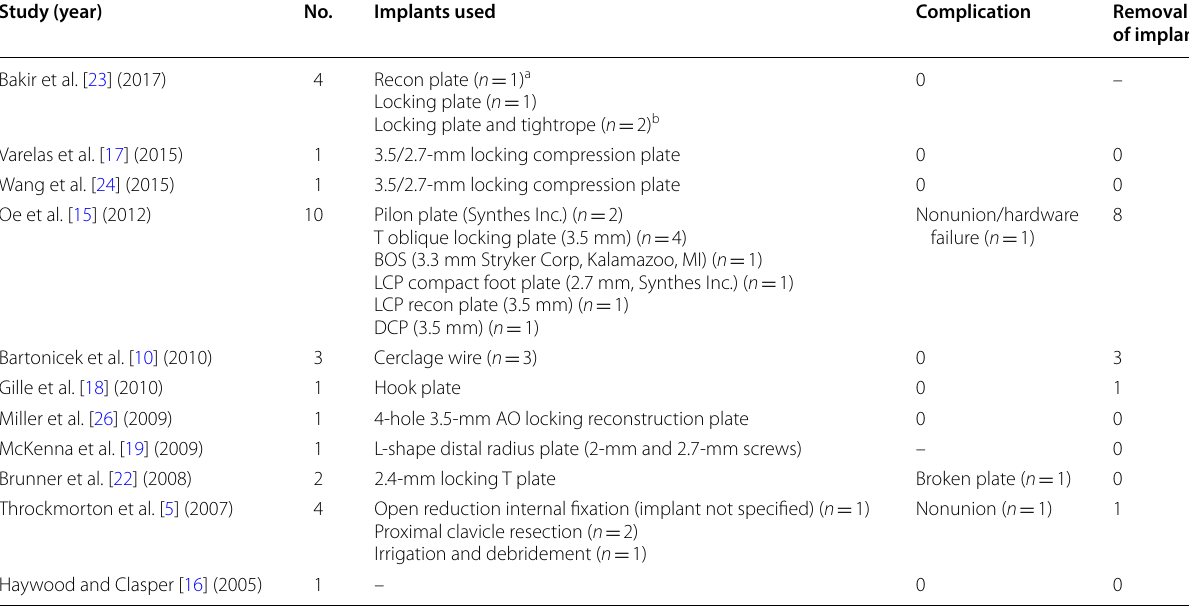
Table 3 Implants and complication profile associated with operative management of medial clavicle